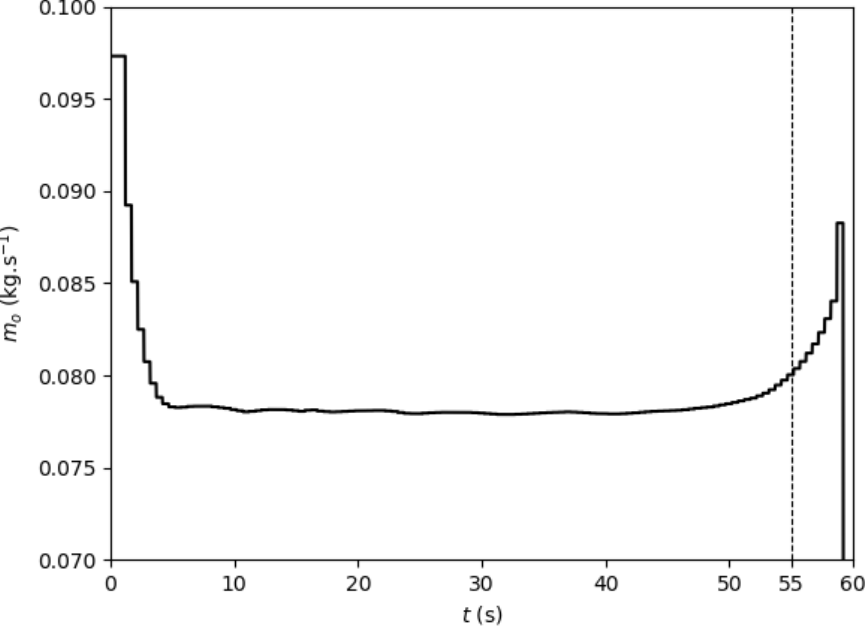
Figure 20. Oxidizer mass flow rate profile, feedback with complete regulation law, case 1.